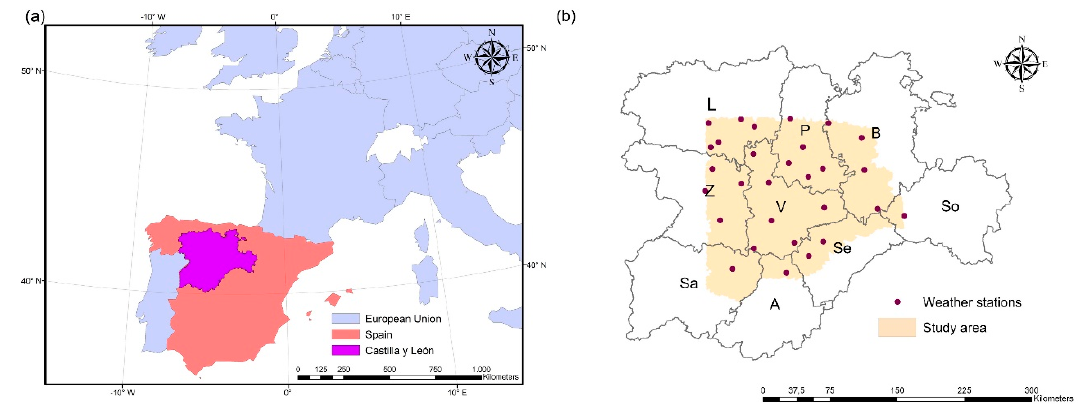
Figure 1. ( a ) Location of the region under study (Castilla-y-León) in Europe. ( b ) Location of the weather stations (red dots) and the sugar beet cultivation area covered in this study (in yellow). Administrative divisions of the region (provinces) are also shown. Province codes are as follows: L (León), P (Palencia), B (Burgos), Z (Zamora), V (Valladolid), So (Soria), Sa (Salamanca), A (Ávila), and Se (Segovia).